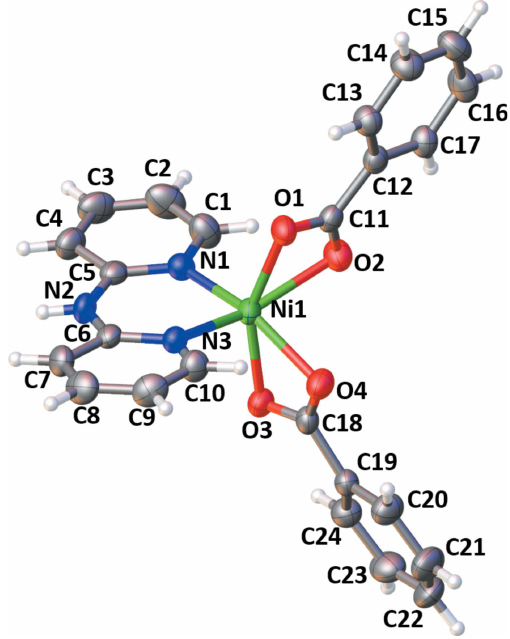
Figure 1 ORTEP representation of the title complex with the atom numbering. Displacement ellipsoids are drawn at the 50% probability level.